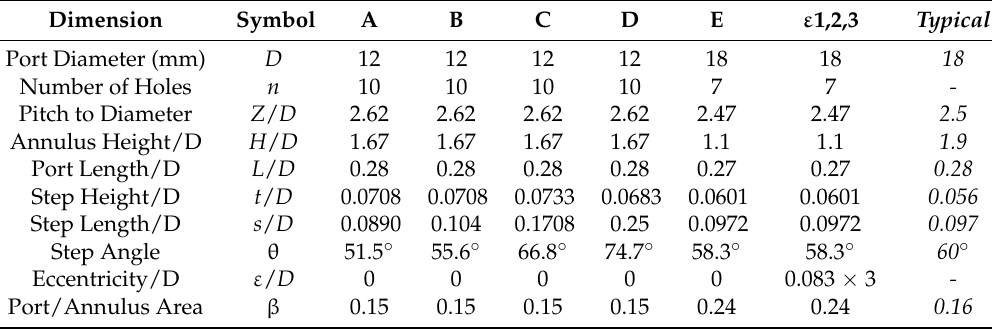
Table 3. Stepped port test configurations, waterflow rig with crossflow.